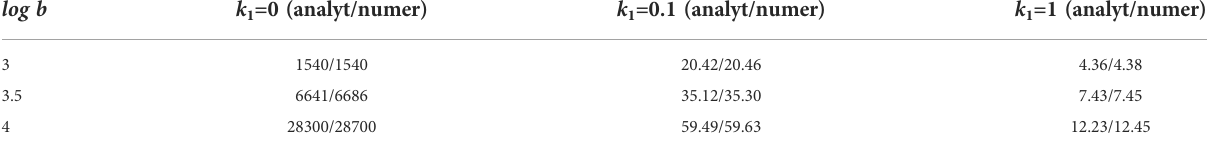
TABLE 1 Analytical and numerical values of the viral load. log